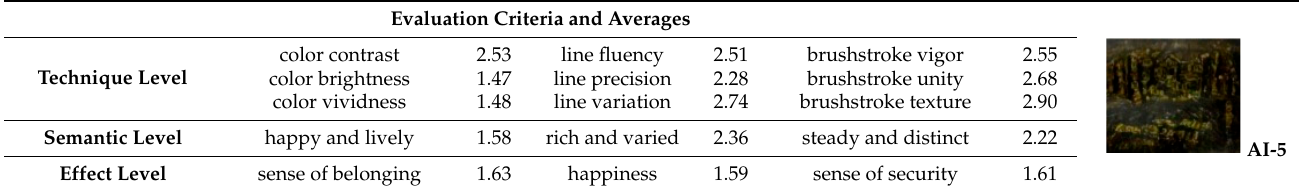
Table 4. Average for affective impact on the theme of Home Sweet Home for the AI. Evaluation Criteria and